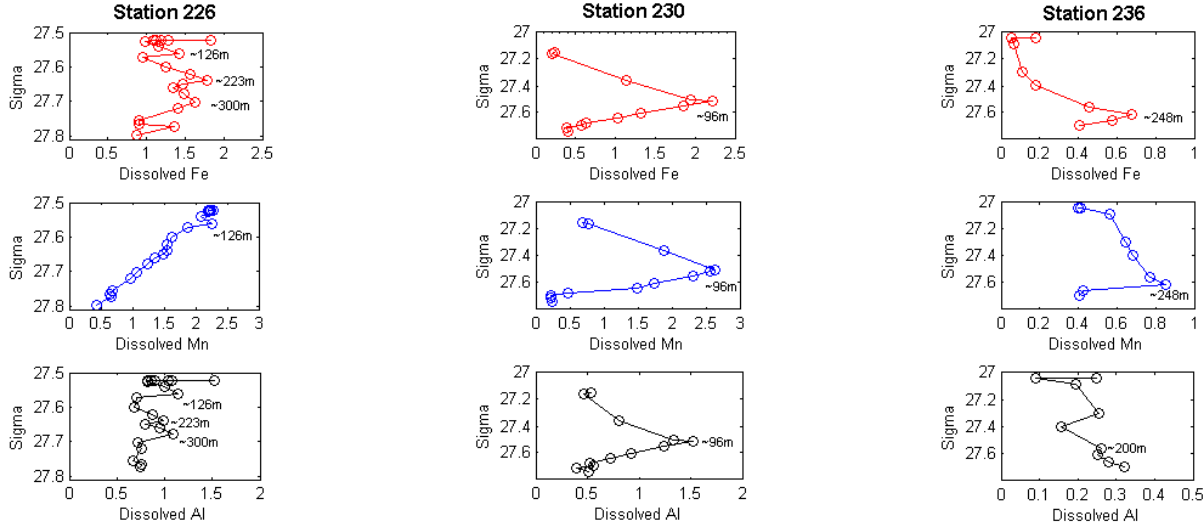
Fig. 9. Sigma theta ( σθ ) vs. Dissolved Fe, Dissolved Mn (Middag et al., 2012) and Dissolved Al (Middag et al., 2012) (nM) for the stations adjacent to Elephant Island (see Fig. 1b). Note the different metal concentration scales for different stations. Also corresponding depths of peak values are